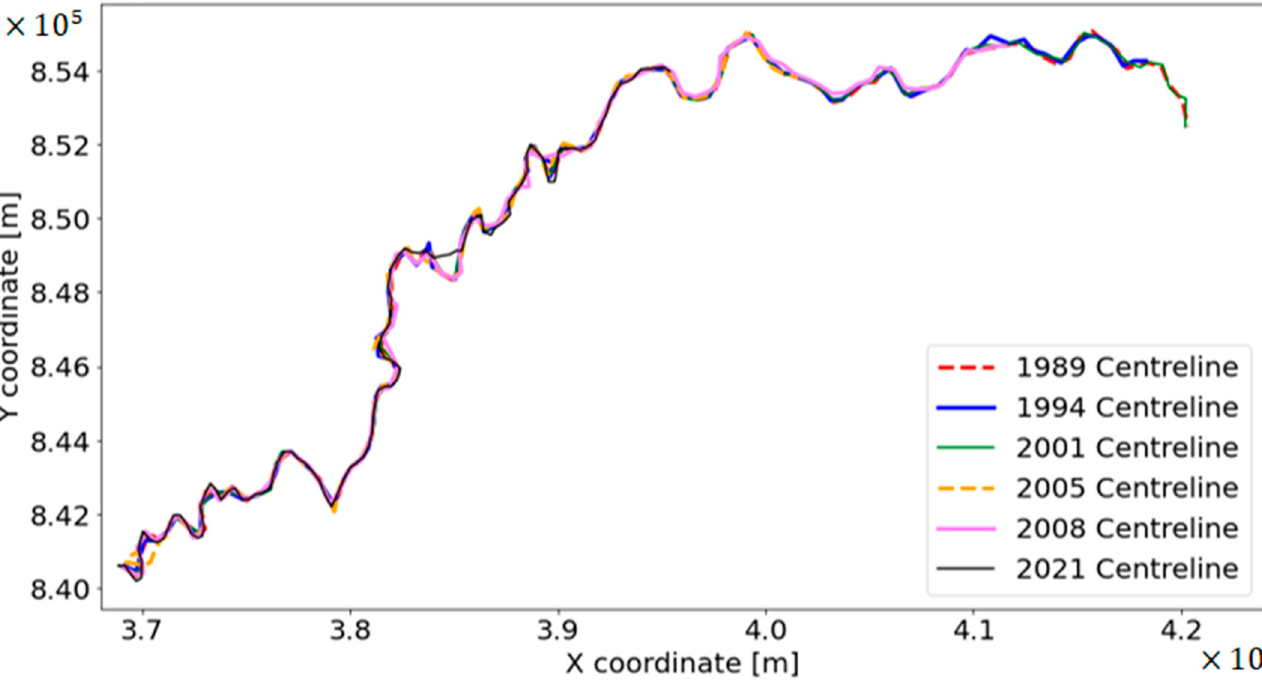
Figure 6. Temporal variation of river centerline.